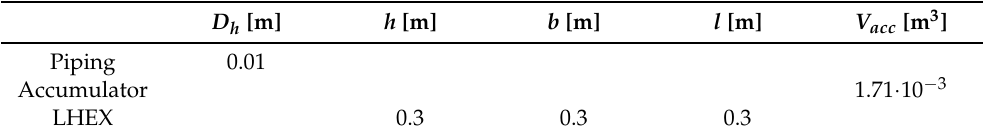
Table 4. Summary of parameter values that are specified by the geometry model but identical for the two different configurations. D h [m] h [m] b [m] Piping